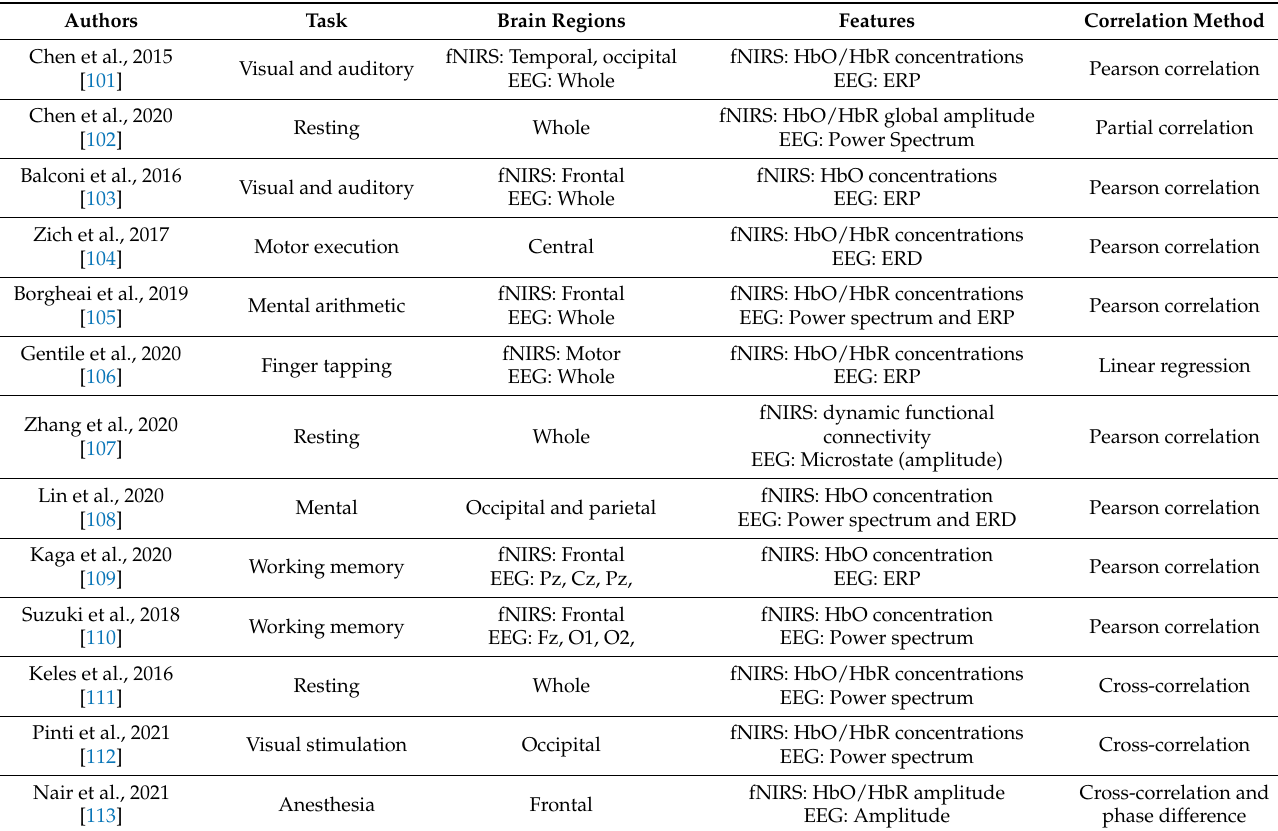
Table 4. Studies using parallel EEG–fNIRS analysis for neurovascular coupling